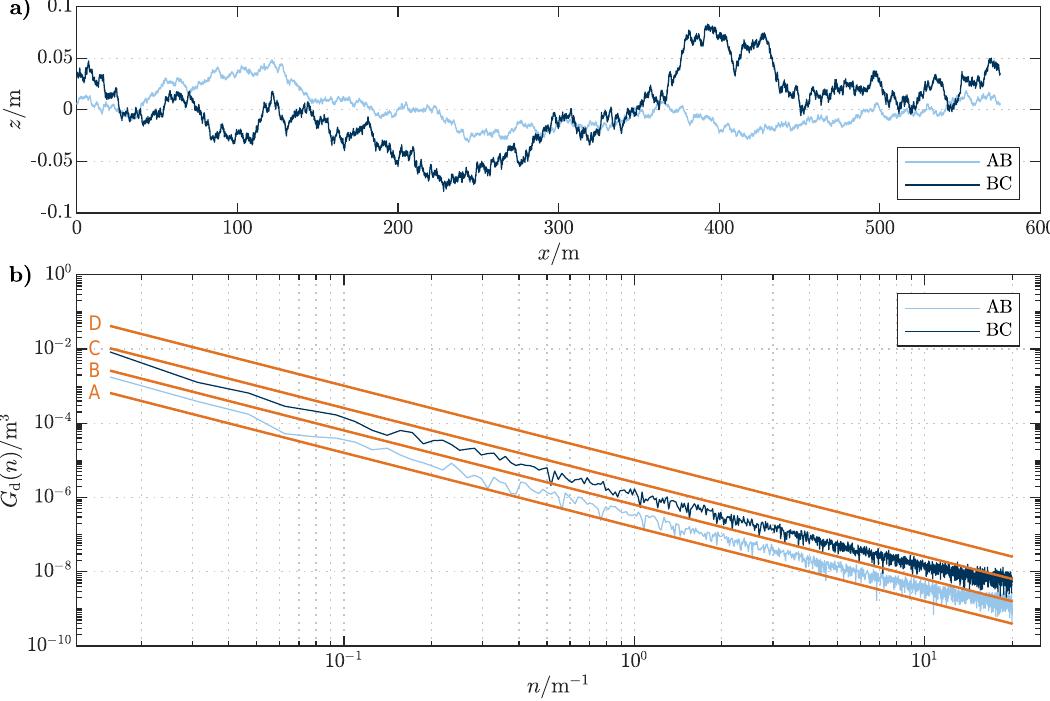
Figure 6. ( a ) Stochastic road-profiles. ( b ) Spatial power spectral density of the stochastic road-profiles. Table 6. Actuator limitations (input constraints) for the single-obstacle scenario. F Ac,lim in kN